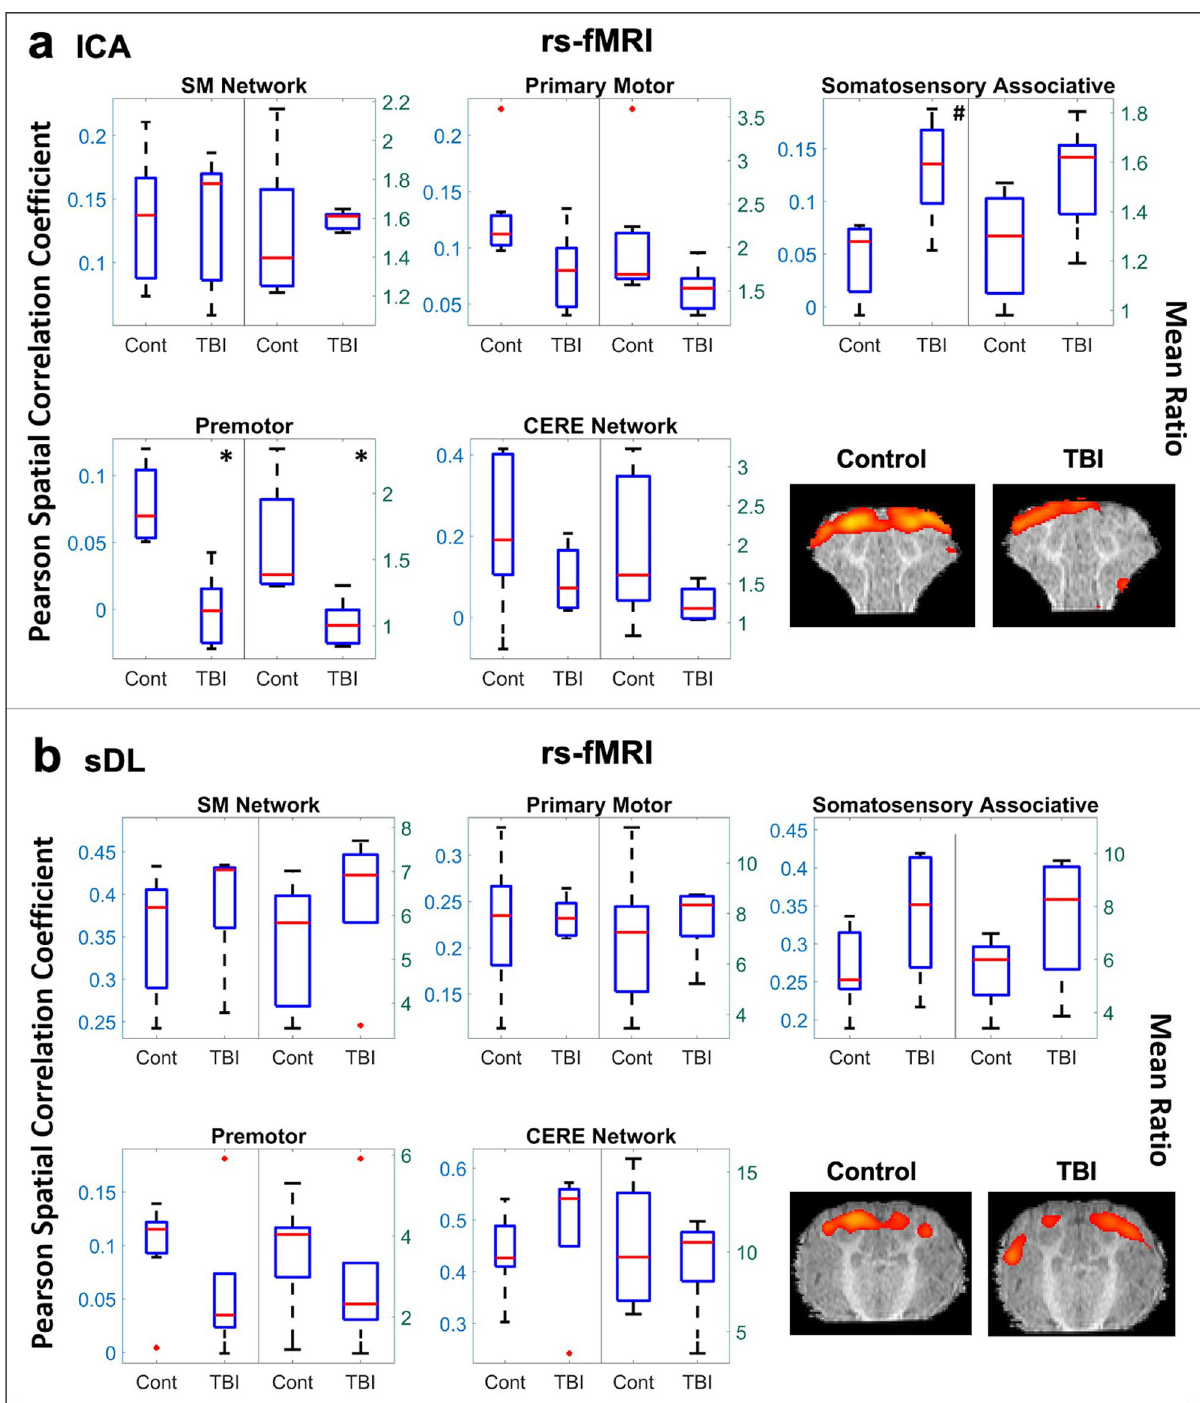
Figure 2. Resting-state (rs-) analysis of the sensorimotor (SM) and cerebellar (CERE) networks. Boxplots of Pearson spatial correlation coefficients (left) and mean ratios (right) obtained from the rs- analysis for the SM network and its individual anatomical regions, as well as the CERE network, obtained using independent component analysis (ICA; a ) and sparse dictionary learning (sDL; b ). The red line denotes the median, the blue box denotes the interquartile range, and the lower and upper whiskers denote the min and max, respectively. An asterisk (*) or pound (#) in the upper right-hand corner indicates significant decrease or increase (p < 0.05), respectively, for the TBI group in comparison to the control group. Representative coronal plane activation maps overlaid on the template pigs’ T1-weighted anatomical image are also displayed. Representative maps in the axial and sagittal plane are provided in the Figures S4 and